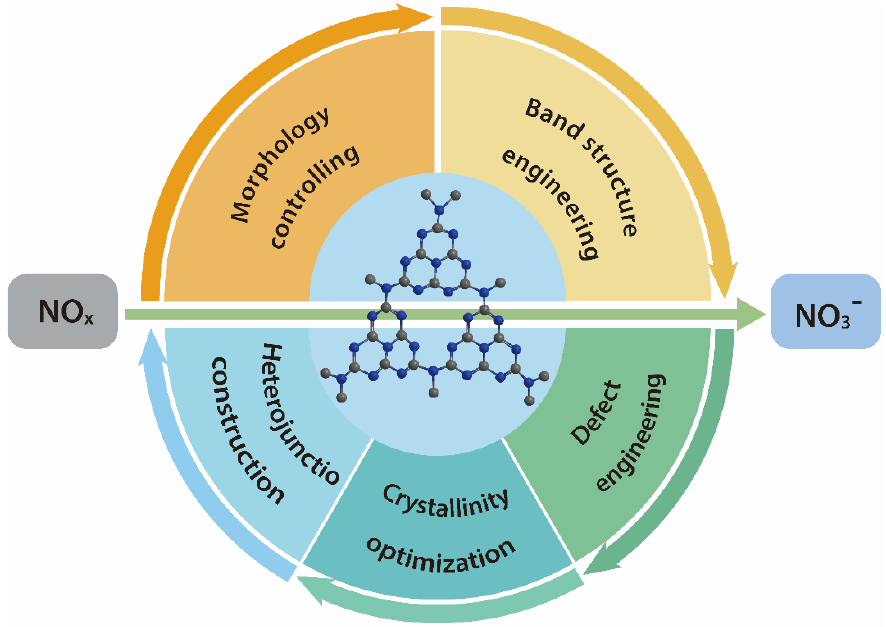
Figure 17. The different modification strategies to improve the photocatalytic NO x removal perfor- mance of g − C 3 N 4 . mance of g − C 3 N 4